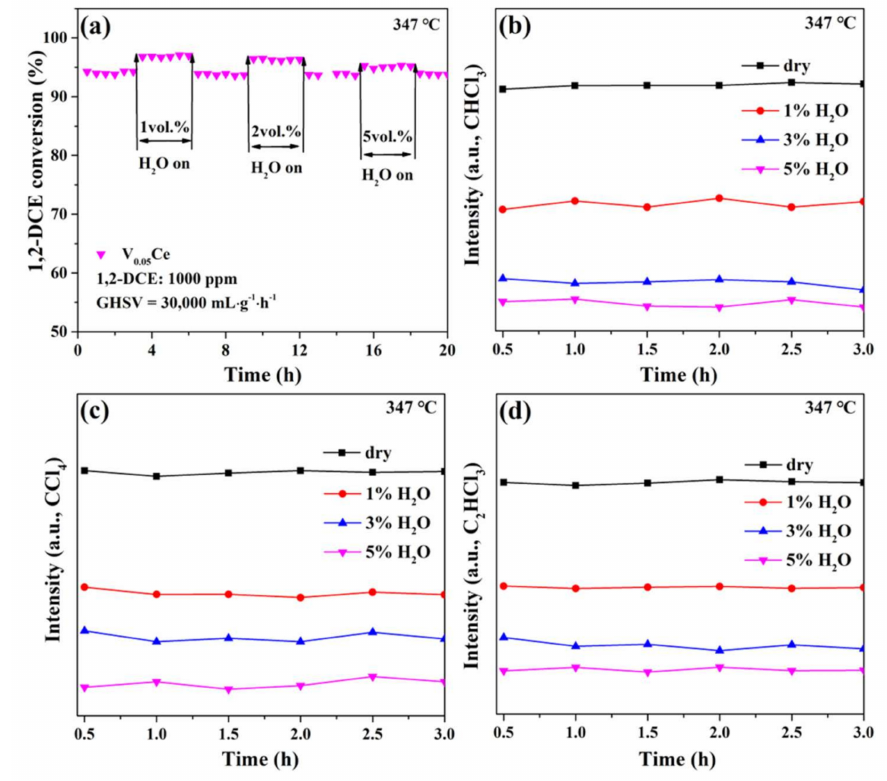
Figure 11. ( a ) Effects of water on 1,2–DCE conversion over V 0.05 Ce catalyst; ( b ) CHCl 3 , ( c ) CCl 4 , and ( d ) C 2 HCl 3 distribution during the stability